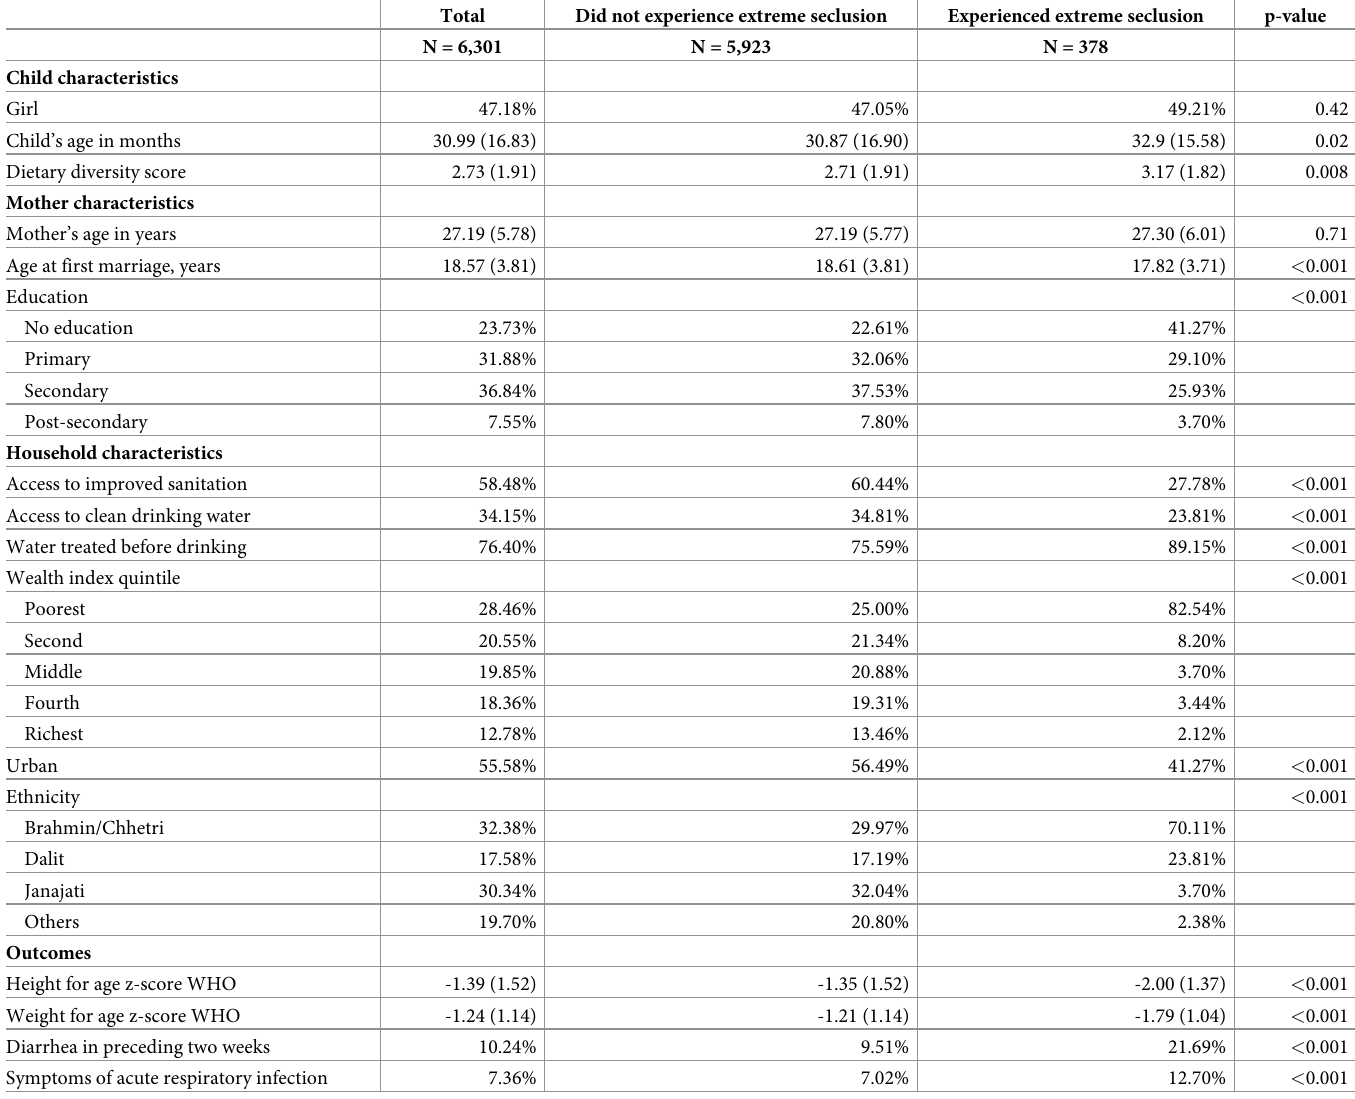
Table 1. Descriptive statistics for the analytic